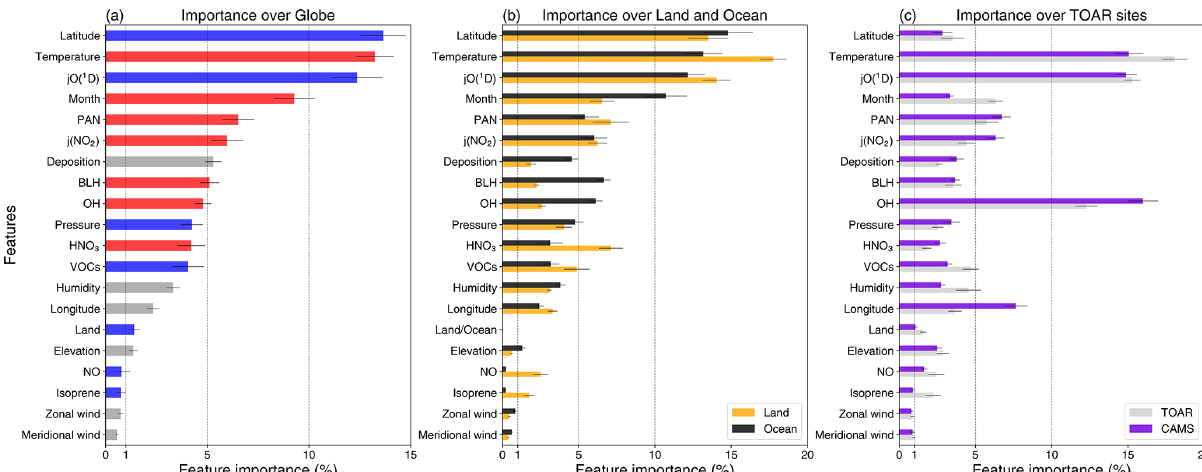
Figure 5. Importance of different variables to surface O 3 biases calculated by the Shapley additive explanations framework (SHAP) for the deep learning model. (a) Feature importance over the globe derived from CAMS reanalysis data. Strong positive ( r > 0.7) and negative ( r < − 0.7) relationships between O 3 biases and variable values are shown in red and blue, respectively, while weaker relationships are shown in grey. (b) Feature importance over land and ocean regions derived from CAMS reanalysis data. (c) Comparison of feature importance inferred from CAMS and TOAR separately at the TOAR measurement locations only. Error bars show one standard deviation of feature importance in % for each